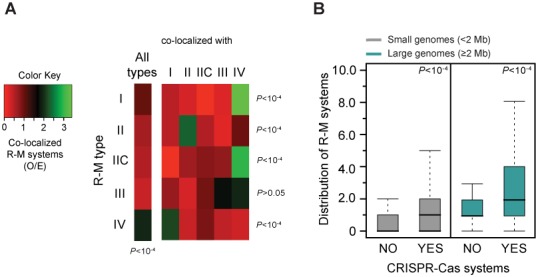
Associations between R-M and other defense systems. (A) Contextual analysis of R-M systems. Observed/expected (O/E) ratios of co-localized R-M systems (all types) and individual R-M types. Expected values were obtained by multiplying the total number of each type of R-M system by the fraction of R-M systems assigned to each MGE. (B) Box plots representing the co-occurrence of R-M and CRISPR-Cas systems in small (<2 Mb) and large (≥2 Mb) genomes. Error bars represent standard deviations. Mann–Whitney–Wilcoxon test P values are indicated.